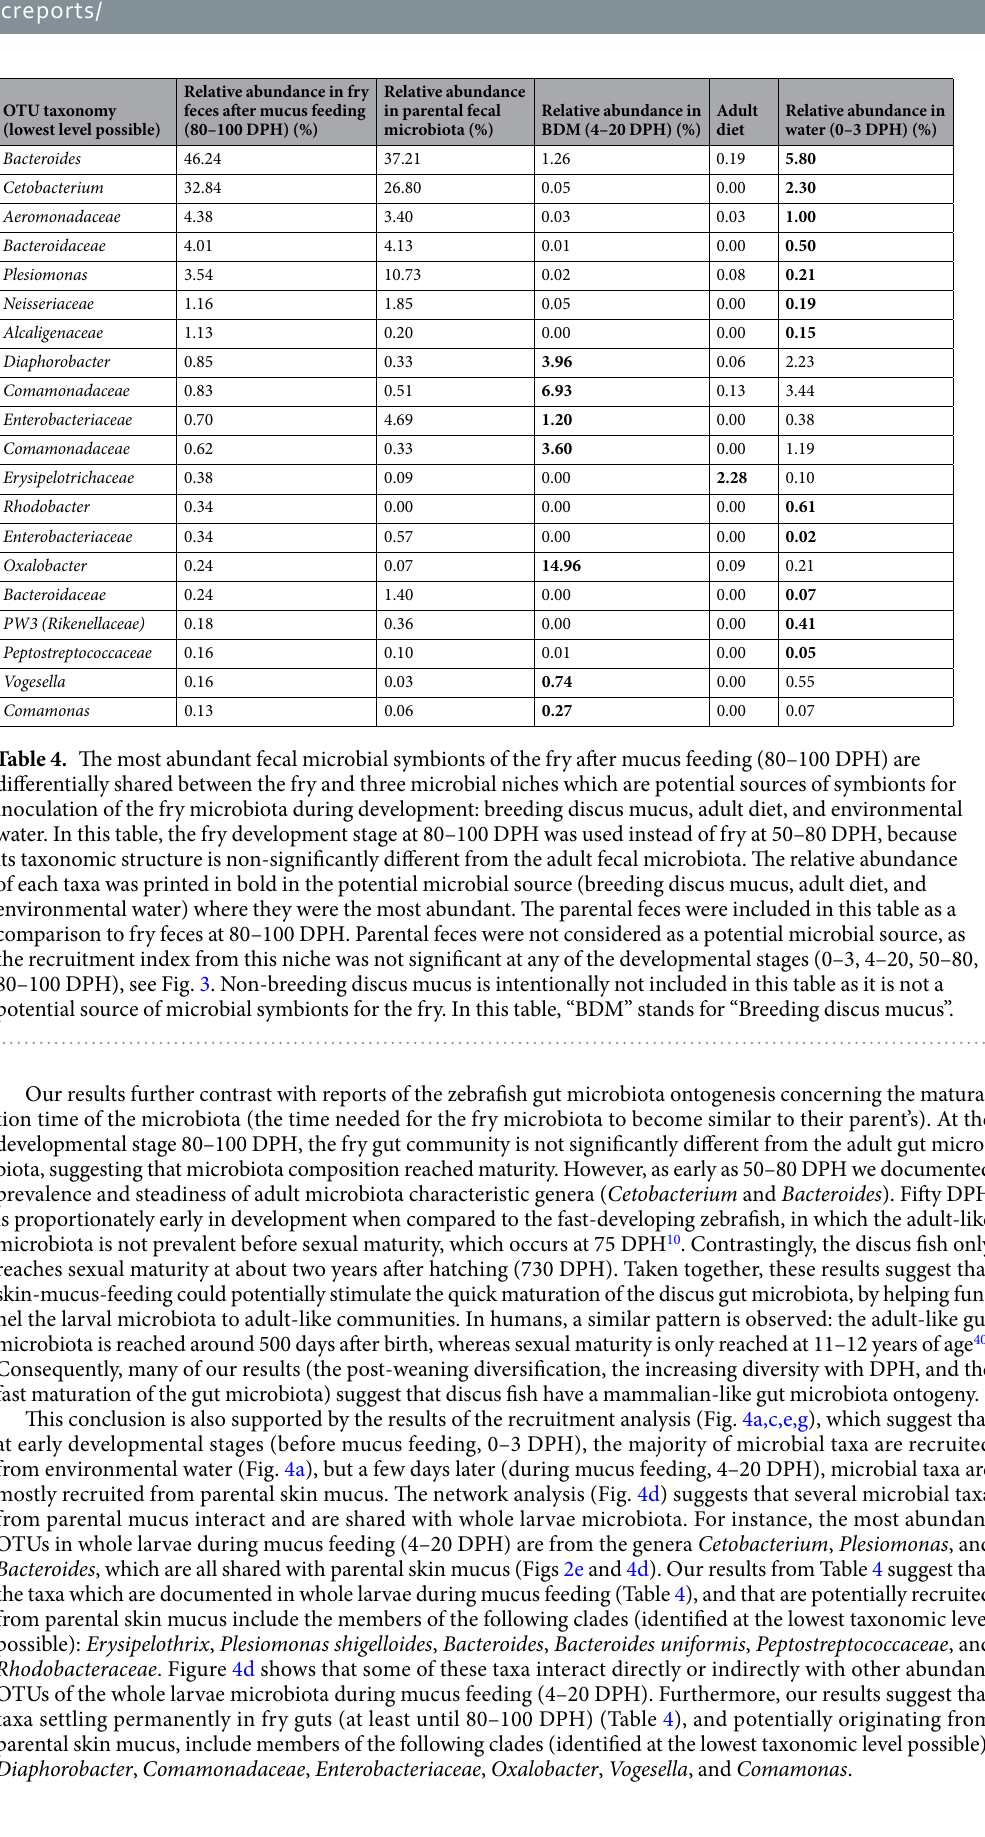
Our results further contrast with reports of the zebrafish gut microbiota ontogenesis concerning the matura- tion time of the microbiota (the time needed for the fry microbiota to become similar to their parent’s). At the developmental stage 80–100 DPH, the fry gut community is not significantly different from the adult gut micro- biota, suggesting that microbiota composition reached maturity. However, as early as 50–80 DPH we documented prevalence and steadiness of adult microbiota characteristic genera ( Cetobacterium and Bacteroides ). Fifty DPH is proportionately early in development when compared to the fast-developing zebrafish, in which the adult-like microbiota is not prevalent before sexual maturity, which occurs at 75 DPH 10 . Contrastingly, the discus fish only reaches sexual maturity at about two years after hatching (730 DPH). Taken together, these results suggest that skin-mucus-feeding could potentially stimulate the quick maturation of the discus gut microbiota, by helping fun- nel the larval microbiota to adult-like communities. In humans, a similar pattern is observed: the adult-like gut microbiota is reached around 500 days after birth, whereas sexual maturity is only reached at 11–12 years of age 40 . Consequently, many of our results (the post-weaning diversification, the increasing diversity with DPH, and the fast maturation of the gut microbiota) suggest that discus fish have a mammalian-like gut microbiota ontogeny. This conclusion is also supported by the results of the recruitment analysis (Fig. 4a,c,e,g), which suggest that at early developmental stages (before mucus feeding, 0–3 DPH), the majority of microbial taxa are recruited from environmental water (Fig. 4a), but a few days later (during mucus feeding, 4–20 DPH), microbial taxa are mostly recruited from parental skin mucus. The network analysis (Fig. 4d) suggests that several microbial taxa from parental mucus interact and are shared with whole larvae microbiota. For instance, the most abundant OTUs in whole larvae during mucus feeding (4–20 DPH) are from the genera Cetobacterium , Plesiomonas , and Bacteroides , which are all shared with parental skin mucus (Figs 2e and 4d). Our results from Table 4 suggest that the taxa which are documented in whole larvae during mucus feeding (Table 4), and that are potentially recruited from parental skin mucus include the members of the following clades (identified at the lowest taxonomic level possible): Erysipelothrix , Plesiomonas shigelloides , Bacteroides , Bacteroides uniformis , Peptostreptococcaceae , and